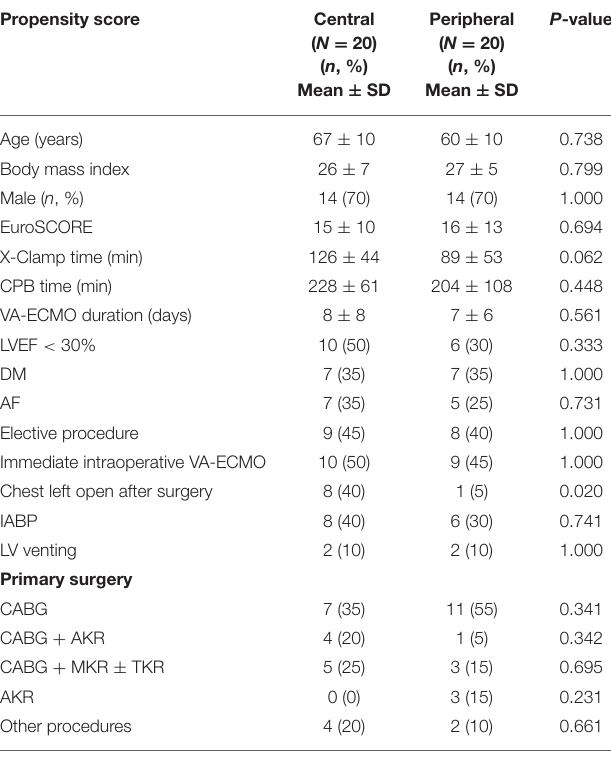
TABLE 3 | Patient characteristics and demographics after propensity score matching. Propensity score